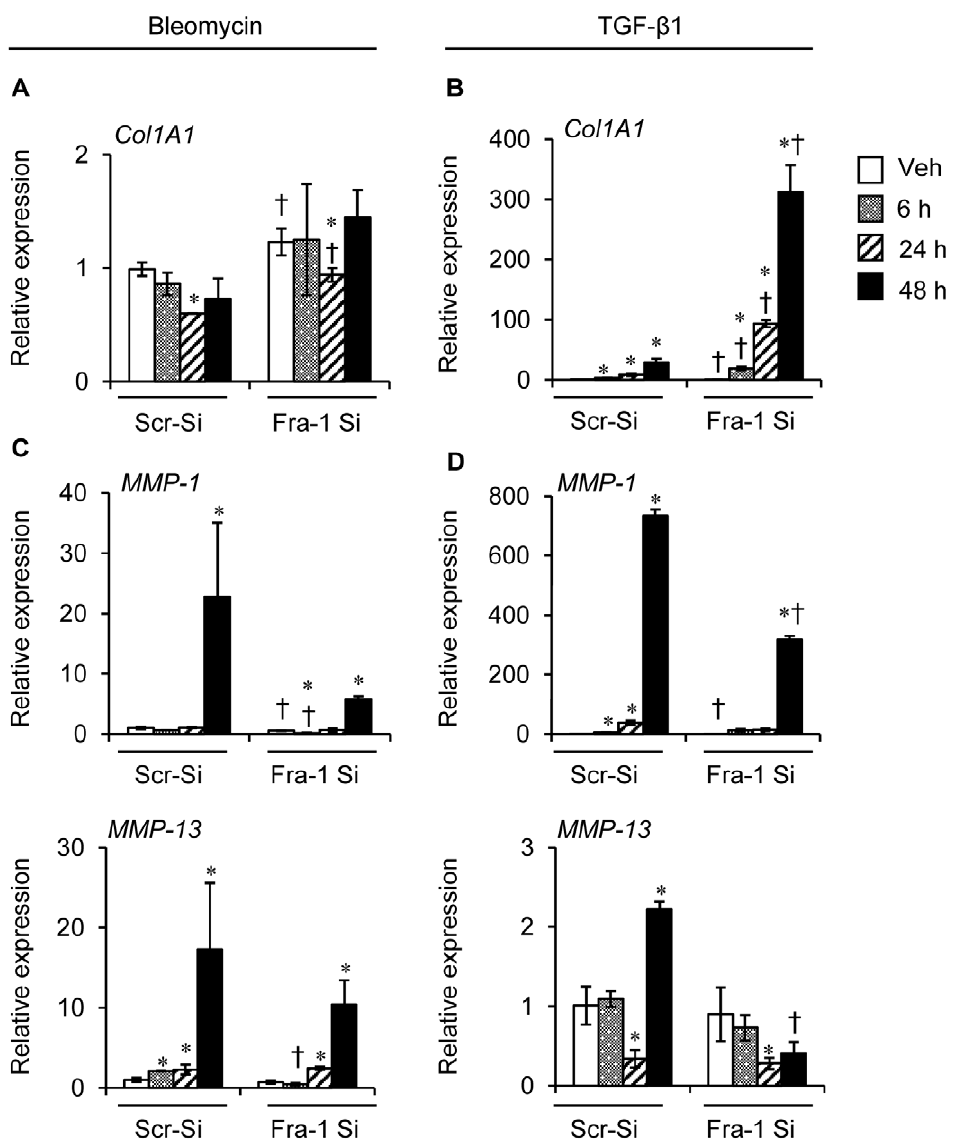
Figure 10. The effects of Fra-1 knockdown on bleomycin- or TGF- b 1-induced fibrotic and anti-fibrotic gene expression in A549 cells. Cells were treated with vehicle or bleomycin (5 ng/ml) or TGF- b 1 (5 ng/ml) for different time points, and harvested for RNA isolation. Col1A1 mRNA expression induced by bleomycin ( A ) and TGF- b 1 ( B ). MMP-1 and MMP-13 mRNA expression induced by bleomycin ( C ) and TGF- b 1 ( D ). Results are mean 6 SD, representative of 2 separate experiments performed in triplicate per group. P , 0.05, PBS vs bleomycin or TGF- b 1; { P , 0,05, Scr-si- RNA vs Fra-1-SiRNA cells at corresponding time points.